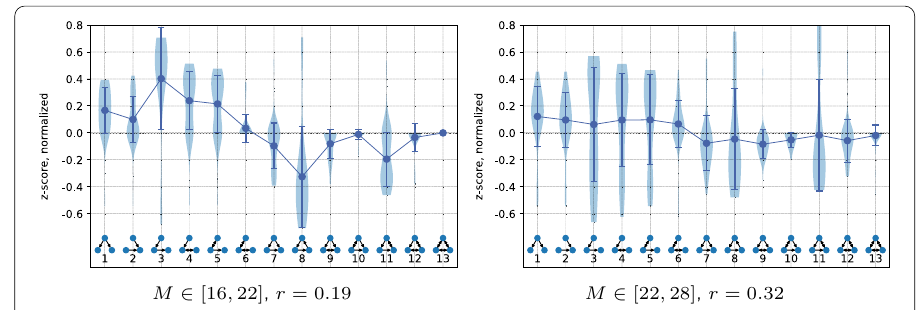
Fig. 5 We generate 50 different network setups with N = 20 and for each setup perform a ( c , r ) optimization with restriction on the allowed number of edges M (shown below each figure). From the resulting Pareto fronts, we take 50 vulnerable networks with given r and compute their motifs. For a single network, the result of motif computations are 13 z‑scores that indicate how over‑ or underrepresented each subgraph is in the original network, compared to its randomized versions. This gives 50 z‑score values for each of the subgraphs that form a distribution drawn with shaded vertical violin plots. Blue circles in the figures are the mean values and vertical lines with ticks are the standard deviations of these distributions